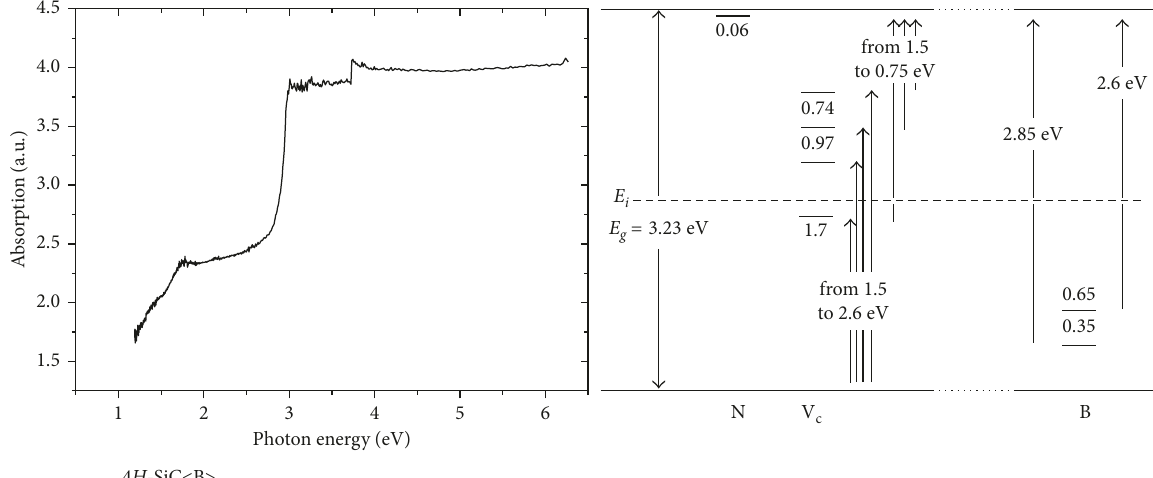
Figure 3: Spectrum of optical absorption of p-n- 4 H -SiC structures doped with boron (measured at room temperature) and the diagram of optical absorption transitions.